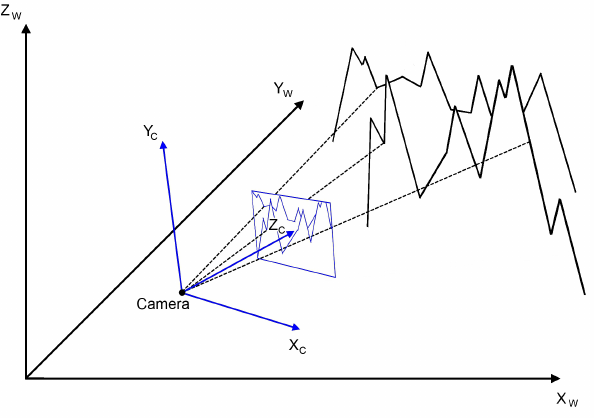
Fig. 4. The principle of the georectification procedure is as follows: at first, the mountain massif in the real world coordinate system (XYZ W , black) is translated and rotated to the camera coordinate system (XYZ C , blue). Then, the 3-D mountain landscape is pro- jected to a 2-D virtual camera image utilising the central projection of the camera lens (adapted from Corripio et al.,